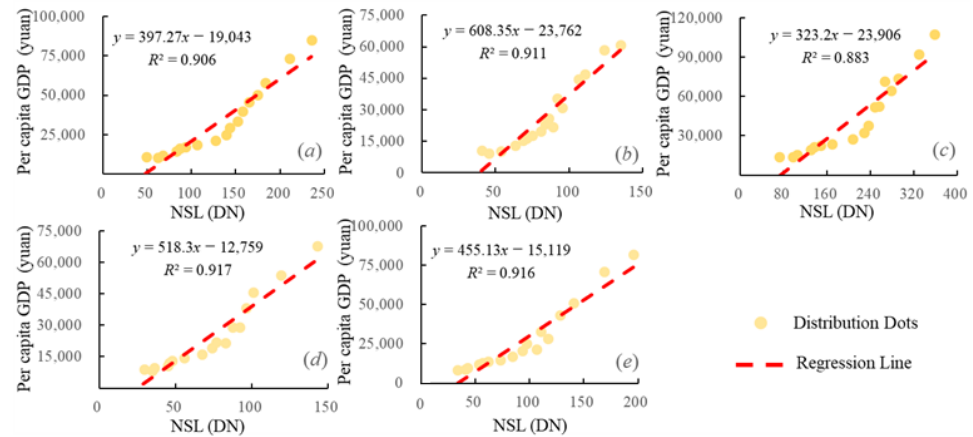
Figure 6. Regression analysis between NSL data and PGDP. All cities ( a ), NER ( b ), ER ( c ), CR ( d ), and WR ( e